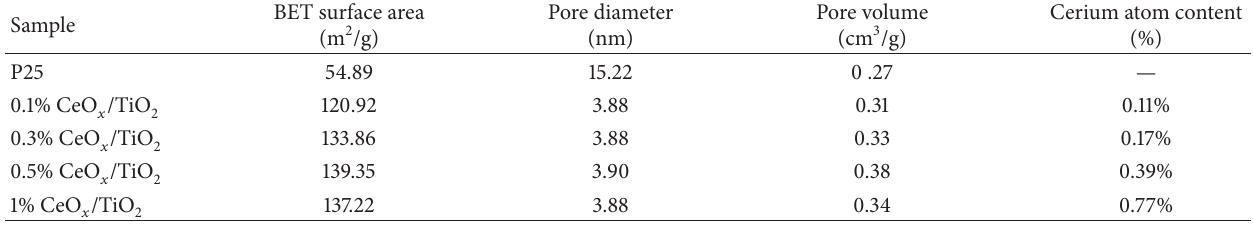
nanoparticles. 2